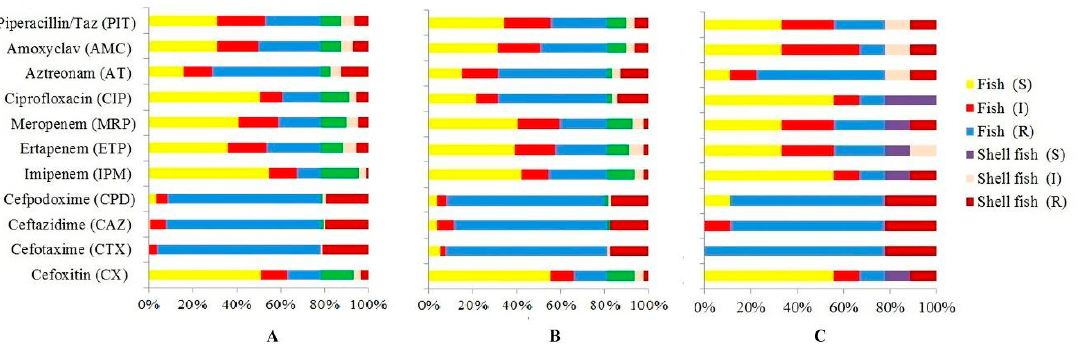
Figure 1. Antibiotic resistance profiles of E. coli harbouring bla CTX-M (n = 212; fish 166, shellfish 46) ( A ), 175 bla SHV (n = 79; fish 64, shellfish 15) ( B ) and bla TEM (n = 9; fish 7, shellfish 2) ( C ). R = resistant, I = 176 Intermediate resistant and S = susceptible. 177